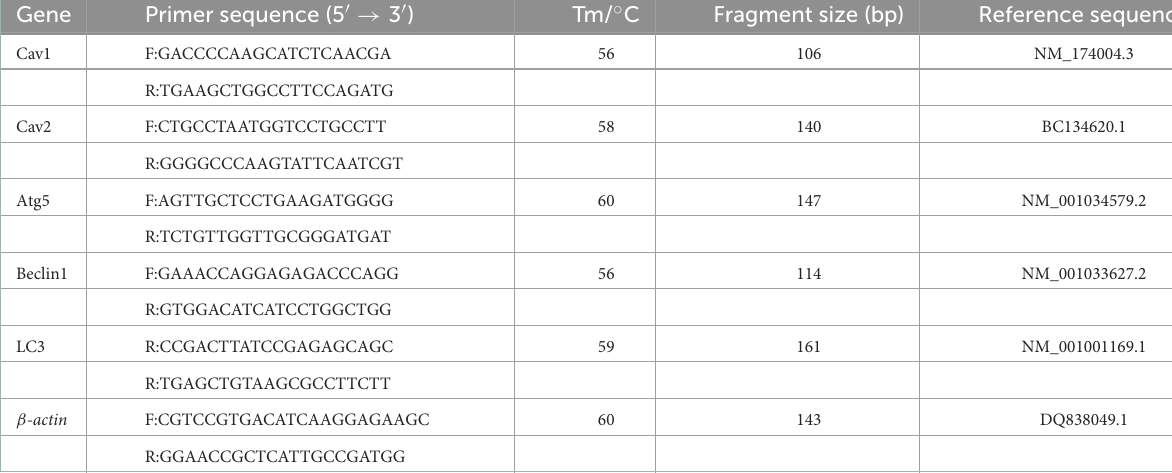
TABLE 1 Primer sequences and cycling conditions used in qRT-PCR.